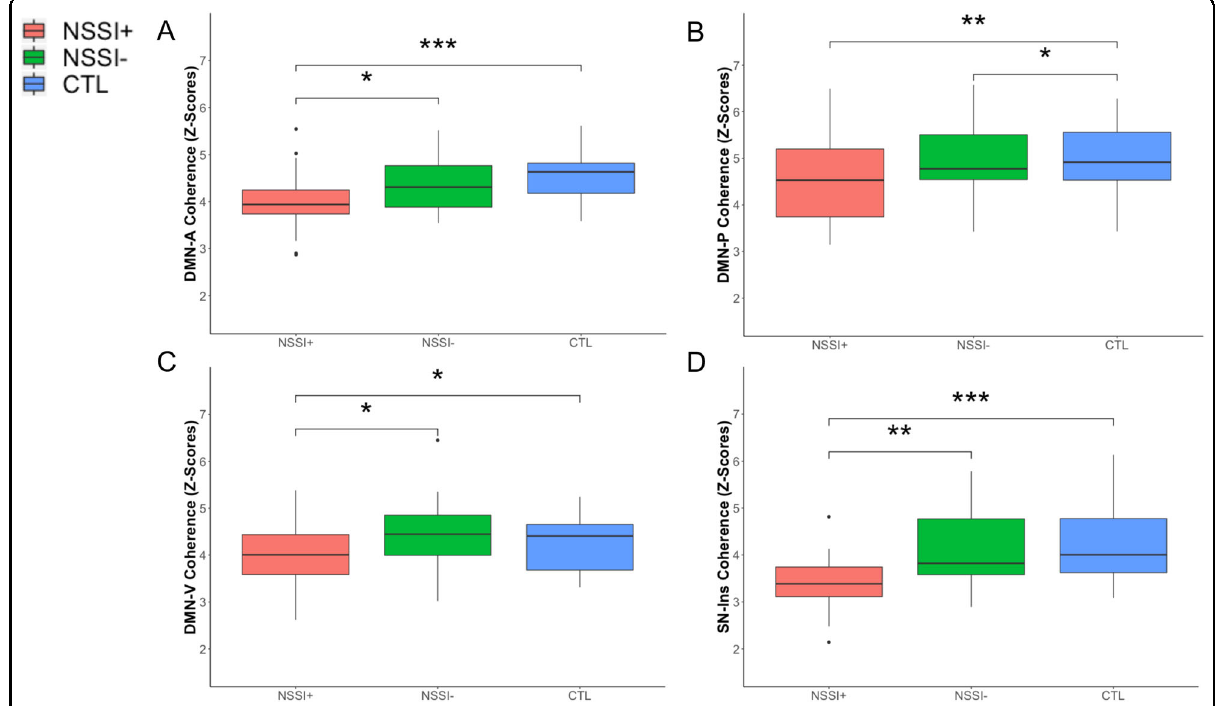
Fig. 3 Network coherence patterns associated with non-suicidal self-injury. NSSI + exhibited signi fi cantly lower network coherence in DMN-A ( a ), DMN-P ( b ), DMN-V ( c ), SN-Ins ( d ) compared to CTL. NSSI + exhibited signi fi cantly lower network coherence in DMN-A ( a ), DMN-V ( c ), and SN-Ins ( d ) compared to NSSI − . NSSI − exhibited signi fi cantly lower network coherence in DMN-P ( b ) compared to CTL. For the purposes of visualization, all box plots depict raw data without adjustment of covariates. See Table 3 and S2 for more details. DMN-A anterior default mode network, DMN-P posterior default mode network, DMN-V ventral default mode network, NSSI non-suicidal self-injury, CTL healthy controls, SN-Ins Salience Network- Insula. * p < 0.05, ** p < 0.01, *** p < 0.001